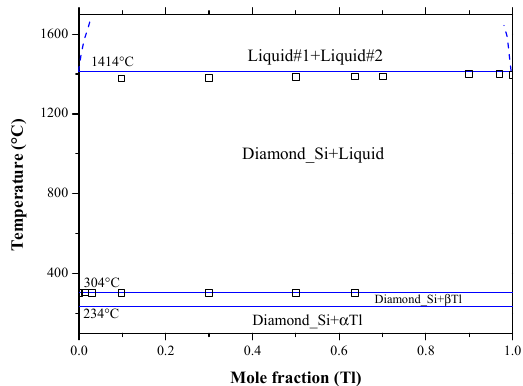
Figure 34. The Si-Tl phase diagram redrawn after Olesinski and Abbaschian [57]. □ : [280]. Very limited thermochemical data of the Si-Tl system could be found in the literature. Thurmond and Kowalchik [120] attempted to describe the Si-Tl liquid in terms of regular solution model. However, Olesinski and Abbaschian [57] considered the calculations of [120] speculative and inaccurate without providing enough justification. The enthalpy of mixing curve is shown in Figure 35 [120]. The positive enthalpy of mixing indicates the existence of a miscibility gap in the Si-Tl system, which agrees with the Si-Tl phase diagram shown in Figure 34. The model parameters of the liquid phase reported by [120] are listed in Table 17.